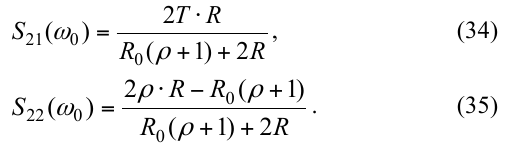
Figure 10: Microwave amplifier cascaded with a shunt series RLC resonant